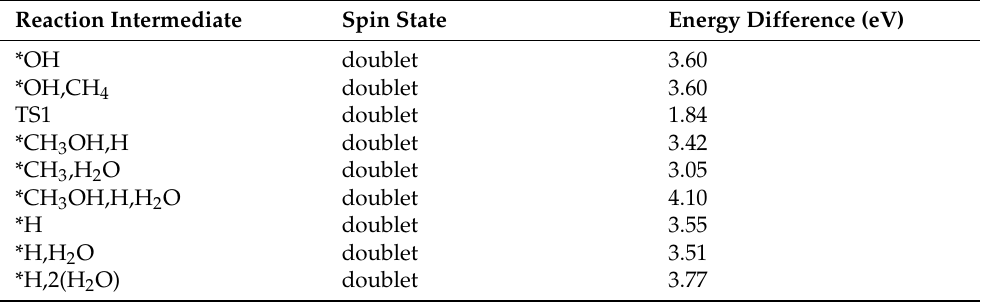
Table 1. Spin state of the intermediates in the reaction over Z 2 [Cu 2 OH] following the reaction mechanisms in Figure 3. Energy difference between the two lowest spin states in